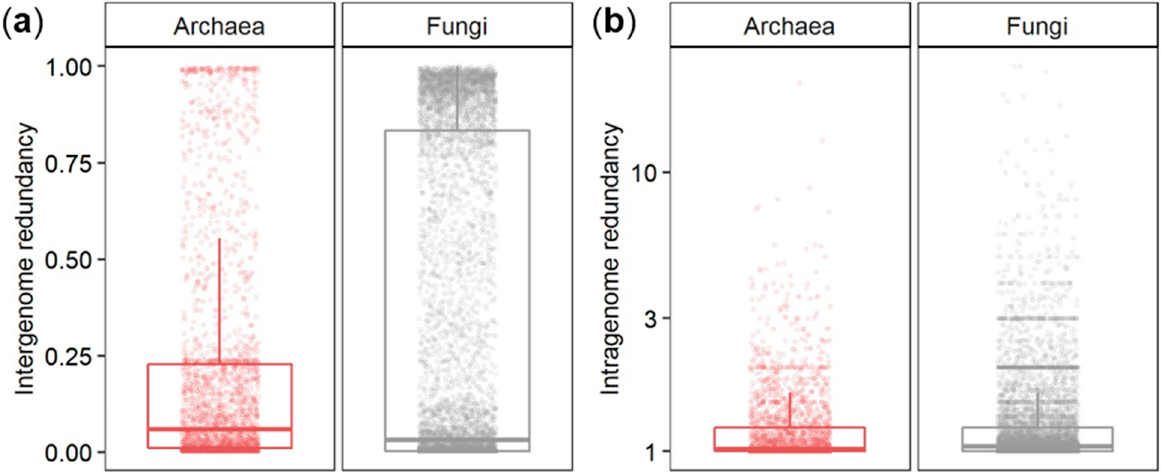
Figure 2. The distribution of intergenome functional redundancy as the total share of functions within archaea relative to the total number of archaeal species in the database ( a ) and intragenome functional redundancy as the number of replicated KEGG functions within one archaeal species in the database ( b ) compared to the previously published distributions in fungi [12].